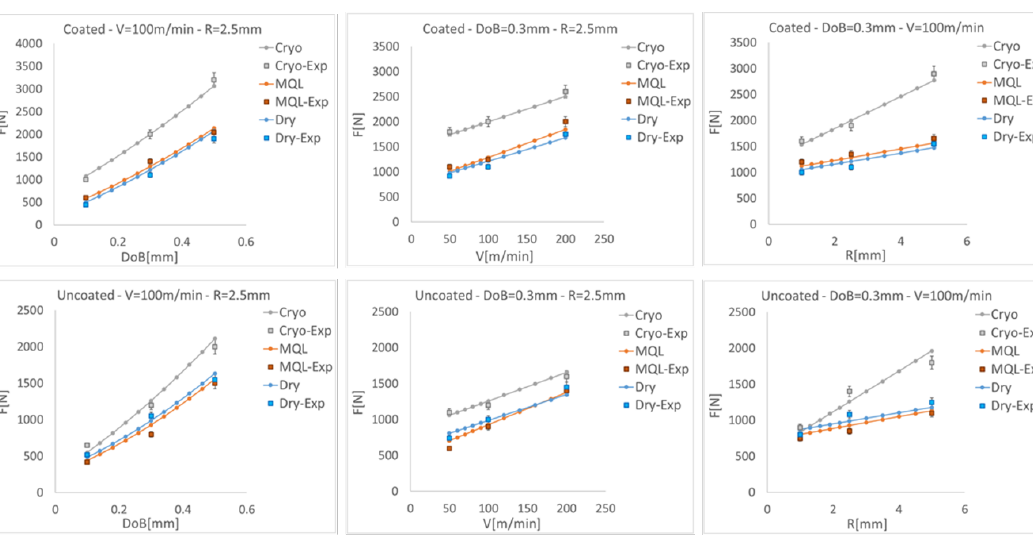
Table 5. Values for force constants in varying lubro / cooling and coating conditions.